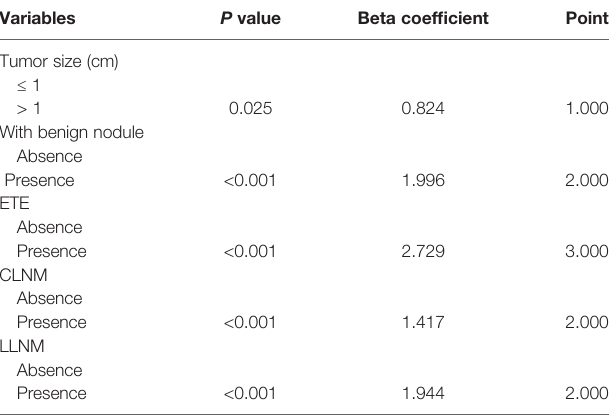
TABLE 6 | Risk scores and percentage of contralateral occult carcinoma in PTC